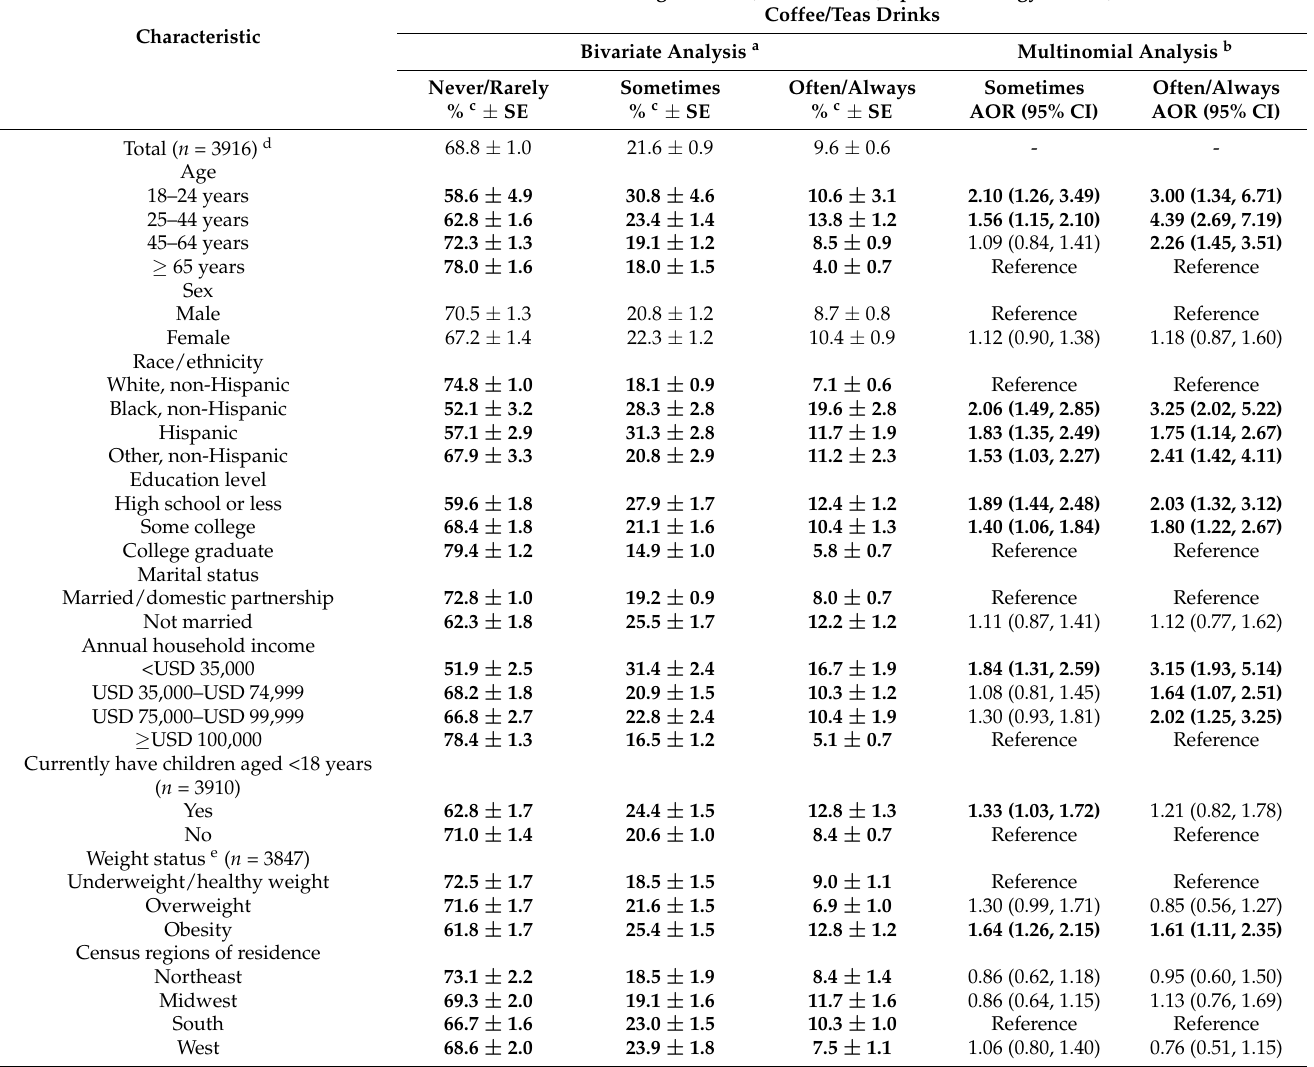
Table 2. Associations between characteristics of respondents and drinking more sugar-sweetened beverages (SSBs) among US adults after the COVID-19 pandemic, SummerStyles Survey, 2020.